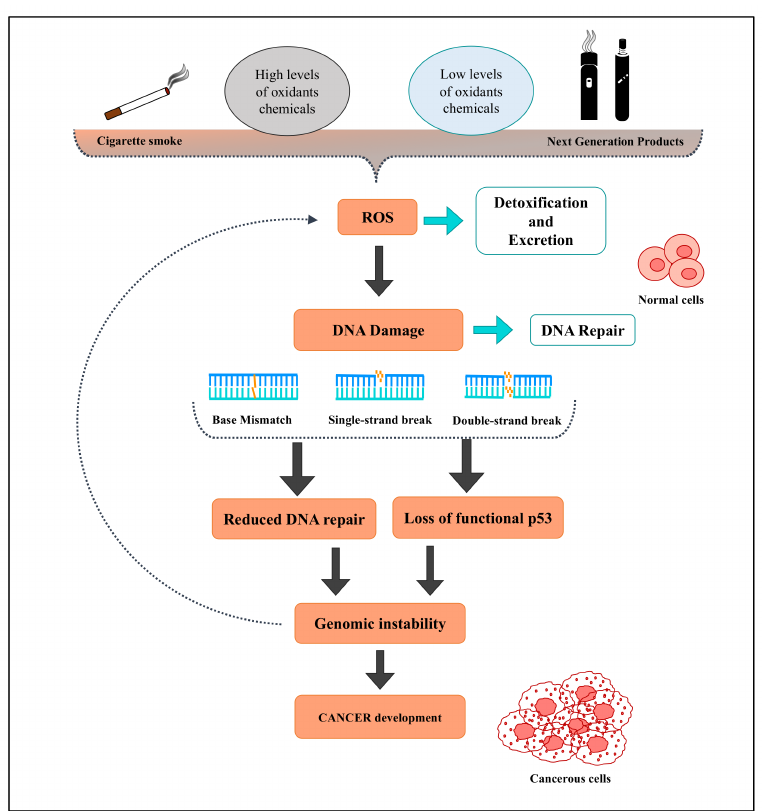
Figure 5. The role of reactive oxygen species (ROS) in the development of cancer. The increase in ROS in normal cells triggers stress responses and DNA repair to repair the ROS-mediated damage to genetic materials. However, the exposure to high levels of oxidants and the consequential redox imbalance lead to DNA damage, including base mismatch, single-strand break, or double-strand break. Moreover, ROS induce DNA mutations that could cause a loss of p53 function and DNA repair disfunction, leading to genomic instability, which further leads to the activation of oncogenes, aberrant metabolic stress, mitochondrial dysfunction, and a decrease in antioxidants. All these events activate a vicious cycle that amplifies oxidative stress and promotes cancer